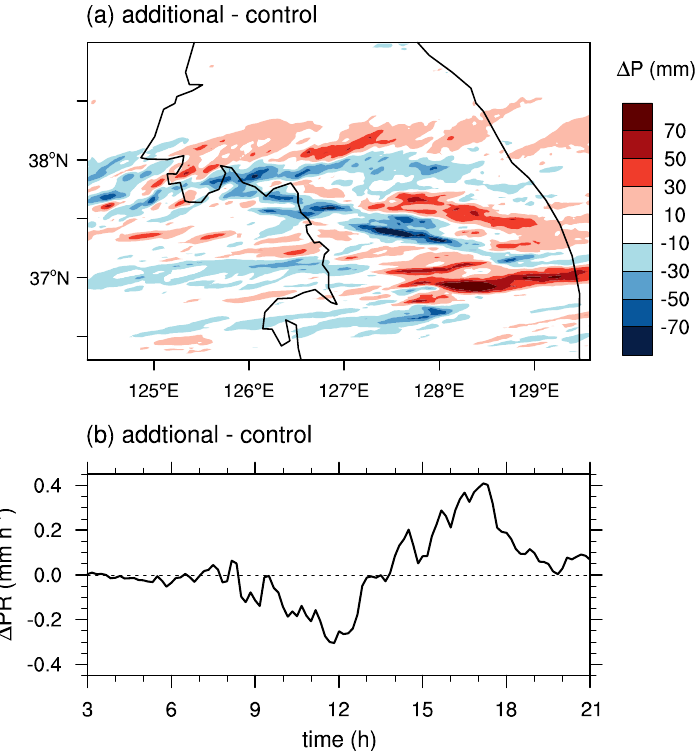
Figure 9. ( a ) Difference in the accumulated surface precipitation amount between the additional simulation that excludes the riming of cloud droplets onto ice crystals in the bin microphysics scheme and the control simulation (conducted using the original bin microphysics scheme). ( b ) Time series of difference in surface precipitation rate between the additional and control simulations.